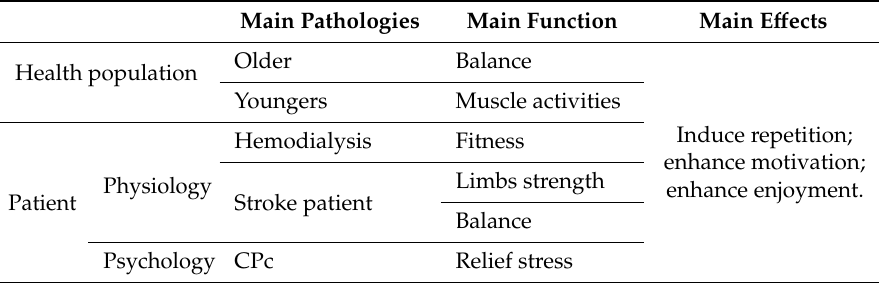
Abbreviations: CPc = Children with Cerebral